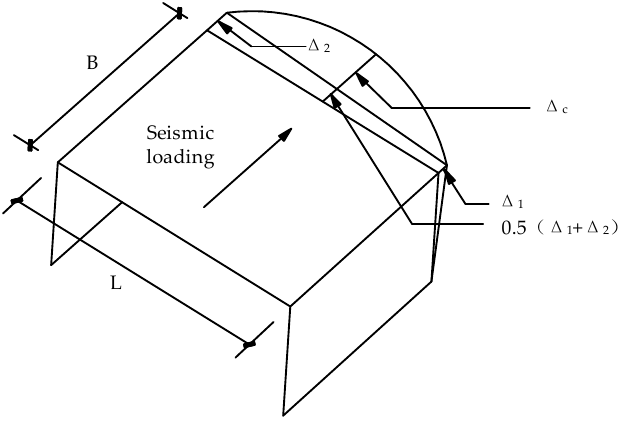
Figure 1. Definition of flexible diaphragm in ASCE 7.